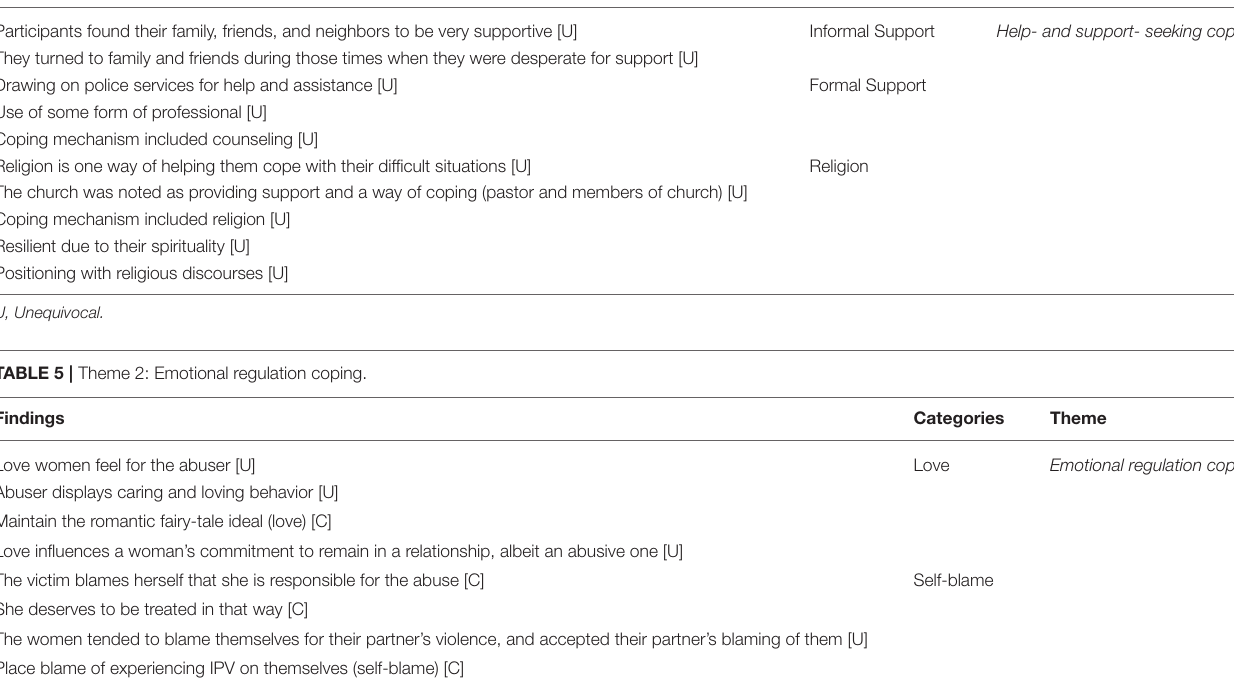
TABLE 4 | Theme 1: Help- and support-seeking coping. Findings